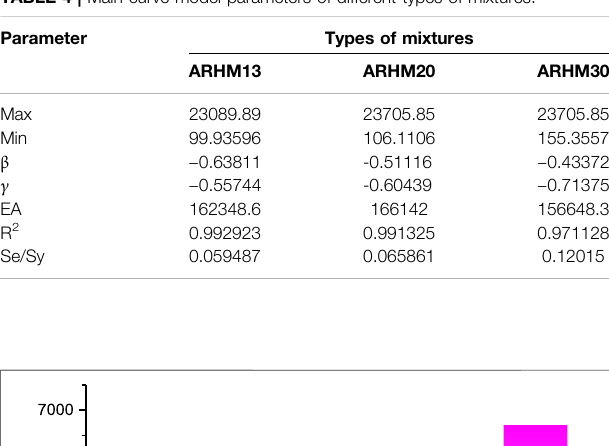
TABLE 4 | Main curve model parameters of different types of mixtures.